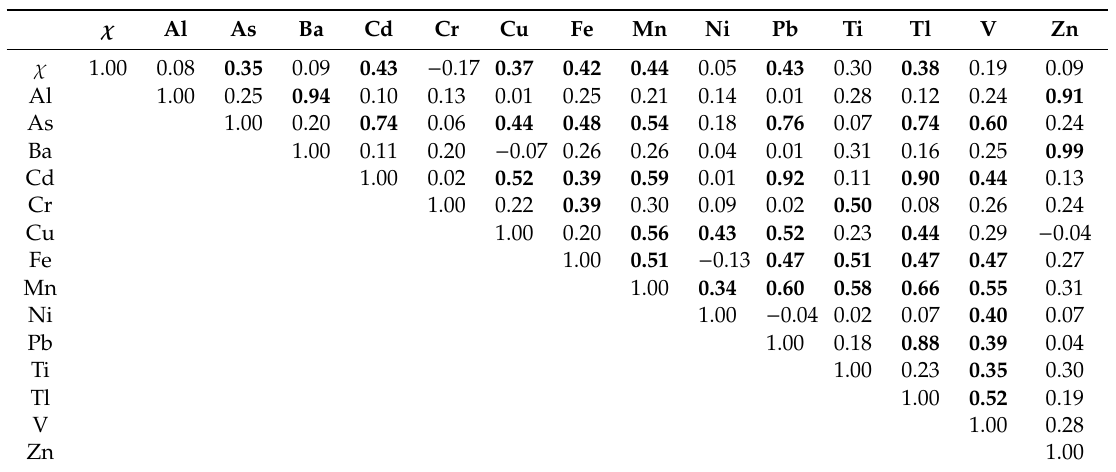
Table 5. Spearman’s rank correlation matrix for TSP ( n =